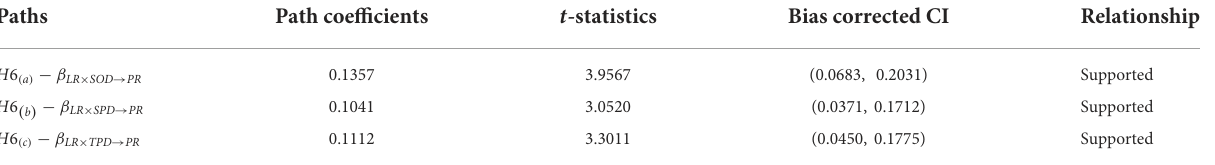
TABLE 5 Direct and moderating